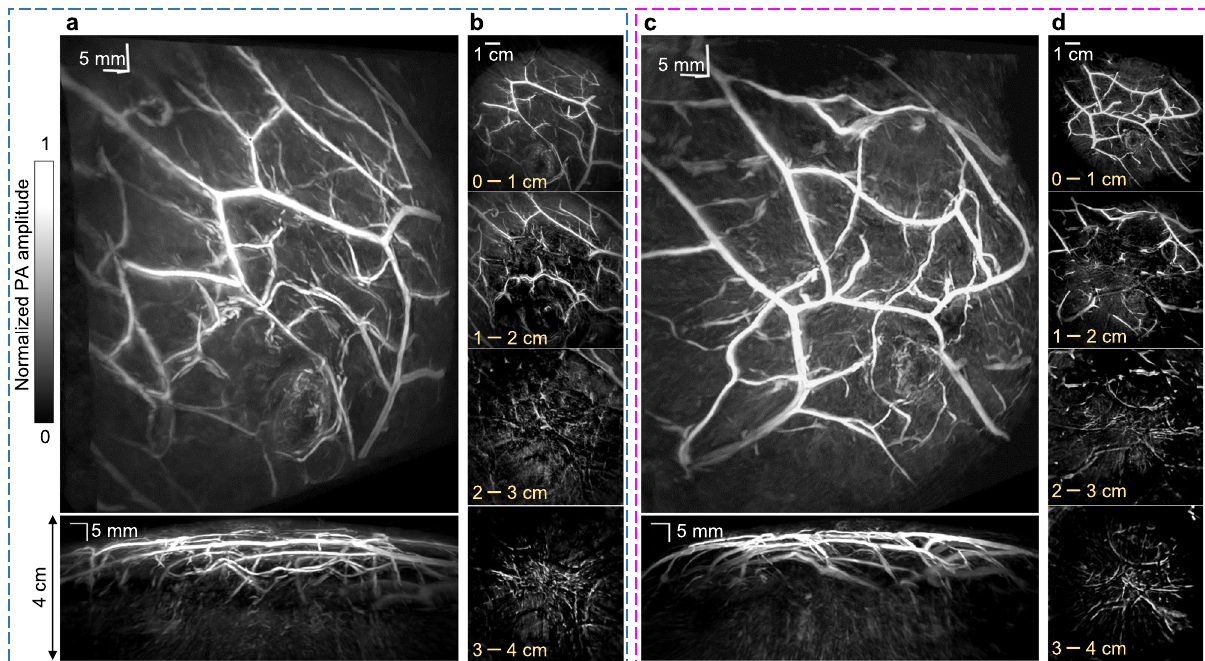
Fig. 4 3D-PACT of human breasts in vivo. a (top) Perspective angiogram of the right breast of a healthy human subject; (bottom) MAP image of the right breast view from the side. An imaging depth of 4 cm from the skin surface has been achieved (Supplementary Movie 3). b Cross-sectional images of the right breast on different coronal planes from the nipple to the chest wall. Each cross-sectional image is an MAP of a 1 cm-thick slice of the breast. c , d Left breast images of the same human subject (Supplementary Movie